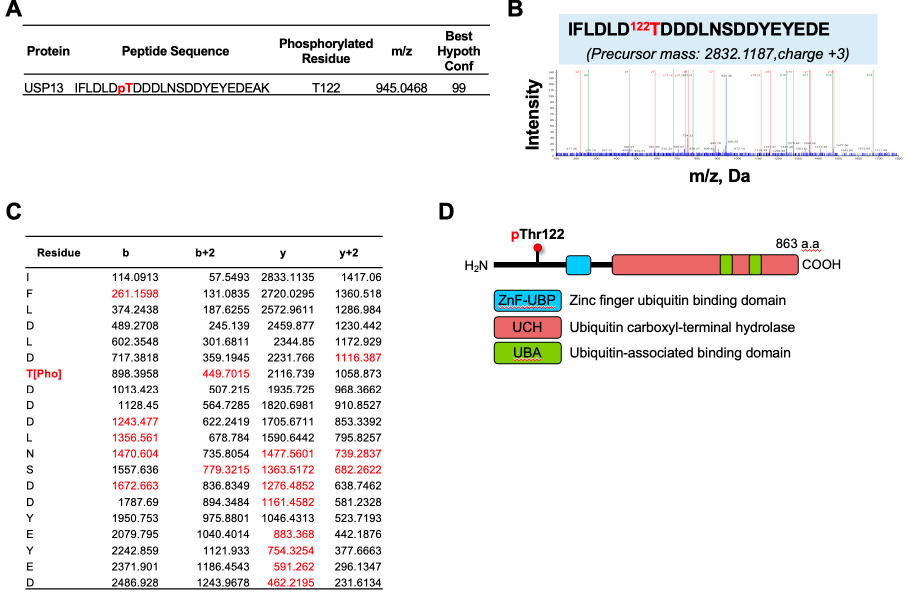
Figure 1. Identification of new phosphorylation site on USP13. ( A ) USP13 phosphorylation site identified by LC-MS/MS in HeyA8 ovarian cancer cells. Peptide sequence, phosphorylation residue, mass-to-charge ratio ( m / z ), and best hypothesis configuration are indicated. ( B ) MS/MS spectrum of IFLDLDTDDDLNSDDYEYEDE peptide with phosphorylation at Thr122 with ions (b = green, y = red). Both b-type and y-type ions were labeled to determine the peptide sequence of the precursor ion and to locate the sites of phosphorylation. ( C ) Matched b-type and y-type ions are shown in red, with phosphorylation at Thr122 unambiguously assigned. b-ions: the charge is retained by the amino-terminal part of the peptide. y-ions: the charge is retained by the carboxyl-terminal part of the peptide. ( D ) USP13 domain structure and Threonine 122 (Thr122) phosphorylation site. Thr122 is located at the N-terminal of USP13 protein, but not in the conserved functional domains.